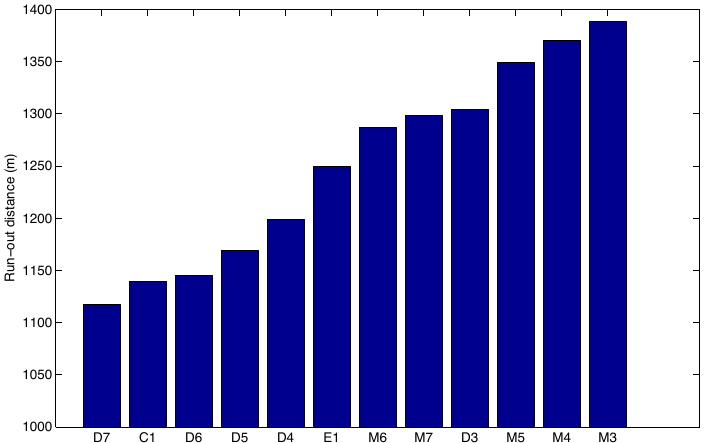
Figure 10. Total run-out distance for all